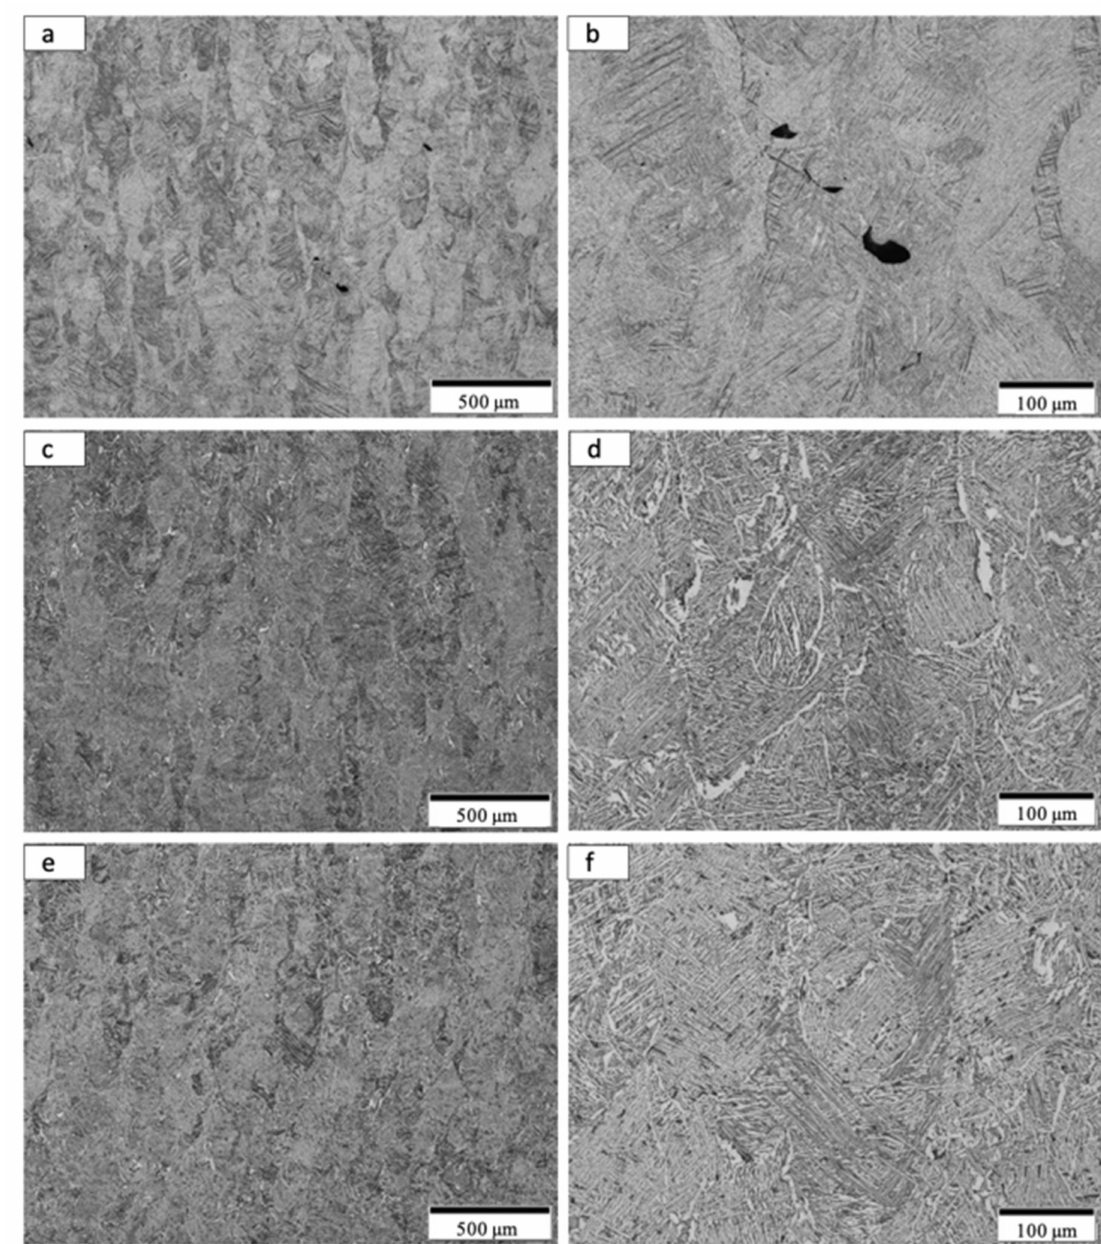
Figure 10. Optical micrographs for Anneal, HIP and HIP + Anneal samples from the build top. ( a , b ) show low and high magnification images for anneal samples. ( c , d ) show low and high magnification images for HIP samples. ( e , f ) show low and high magnification image for HIP + Anneal